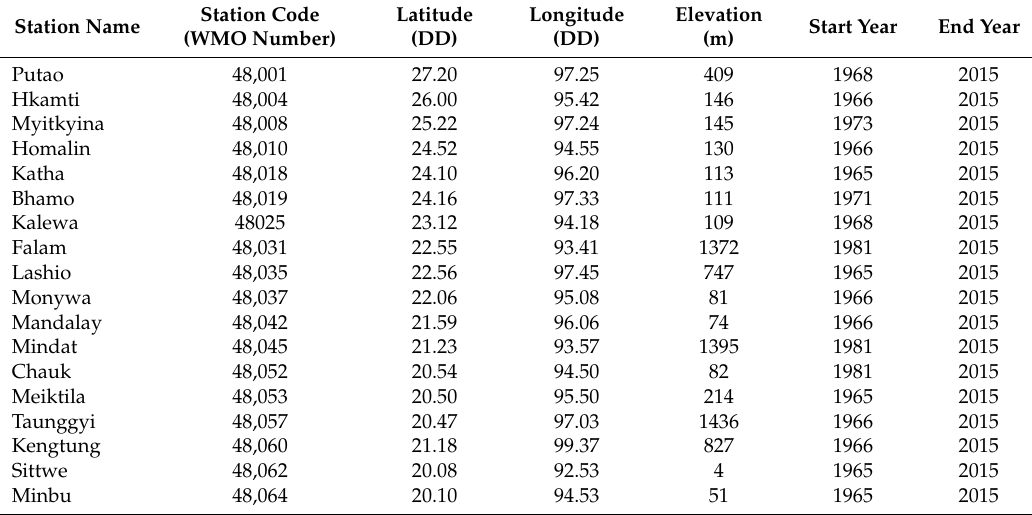
Table 1. Detail information of the meteorological stations used in this study (DMH,